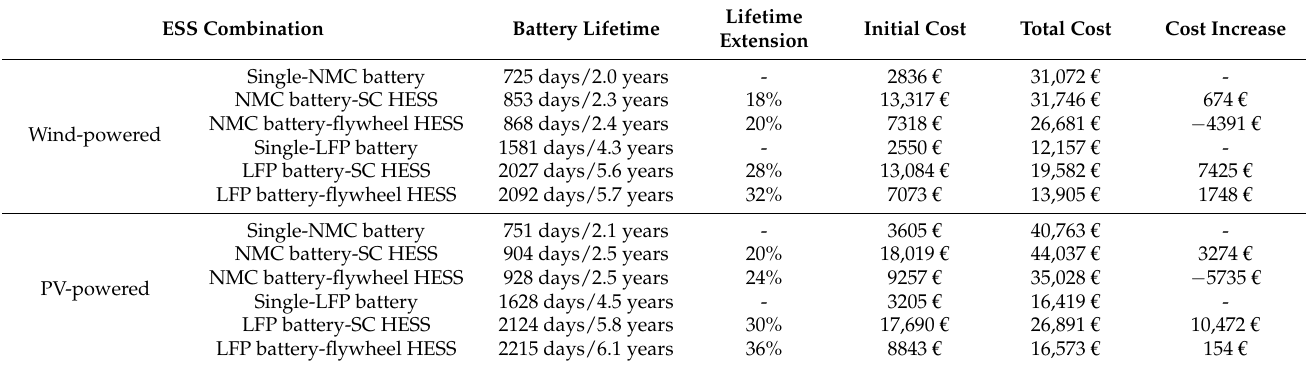
Table 5. Battery lifetime estimation and cost of the energy storage system (30 years project